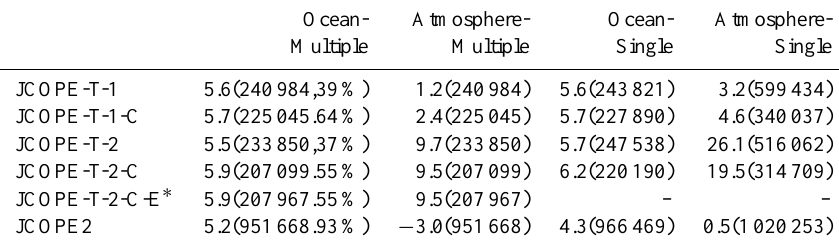
Table 3. Summary of the parameters optimization. Two-digit numbers denote estimated total amounts of 137 Cs emission in PBq. Numbers in parentheses denote the expected costs Eq. (10), except for JCOPE-T-2-C-E. Percent numbers present reduced ratios of the expected cost function values as compared to the first-guess cost function values (see Table 2). “Multiple” (“Single”) means the parameters in the optimization with both the ocean and atmospheric parameters (either single parameter).